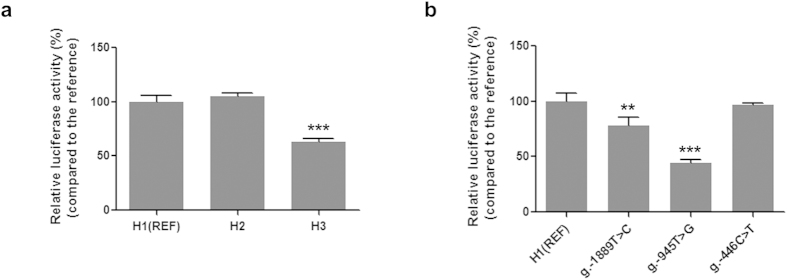
Luciferase activities of the haplotypes or genetic variants of OCTN2 promoter region.The promoter activities were measured 48 hours after transient transfection of the reporter plasmids containing the major OCTN2 haplotypes (a) or genetic variants (b) into HCT-116 cells. Then, the luciferase activity of each construct was compared with that of the reference (REF, H1). The data (mean ± SD) were obtained from triplicate wells. **P < 0.01, ***P < 0.001 vs. reference promoter activity.